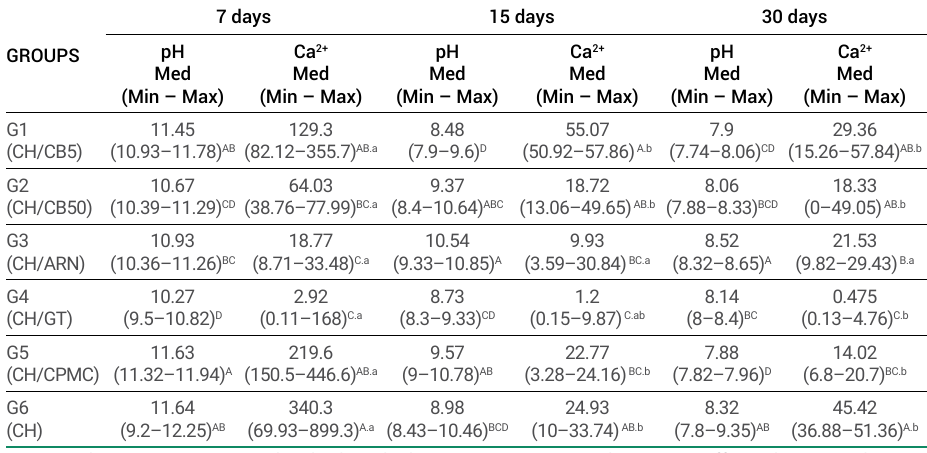
Table 2. Median (Med), minimum and maximum (Min - Max) values for the calcium and hydroxyl ions release (mg/L) from the pastes in the different periods of time.